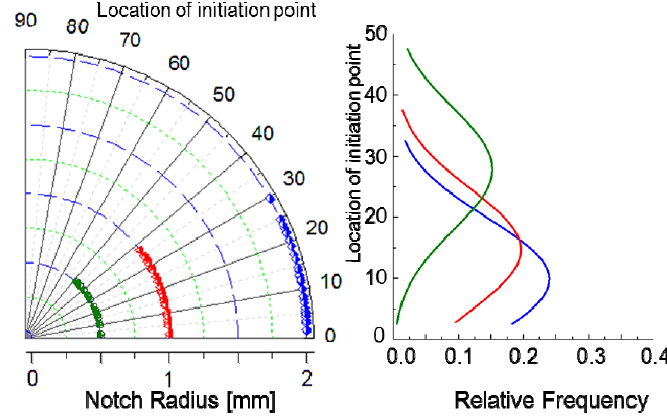
Figure 6: Location of crack initiation point in relation to notch size for a microstructure of 9.74 mm.